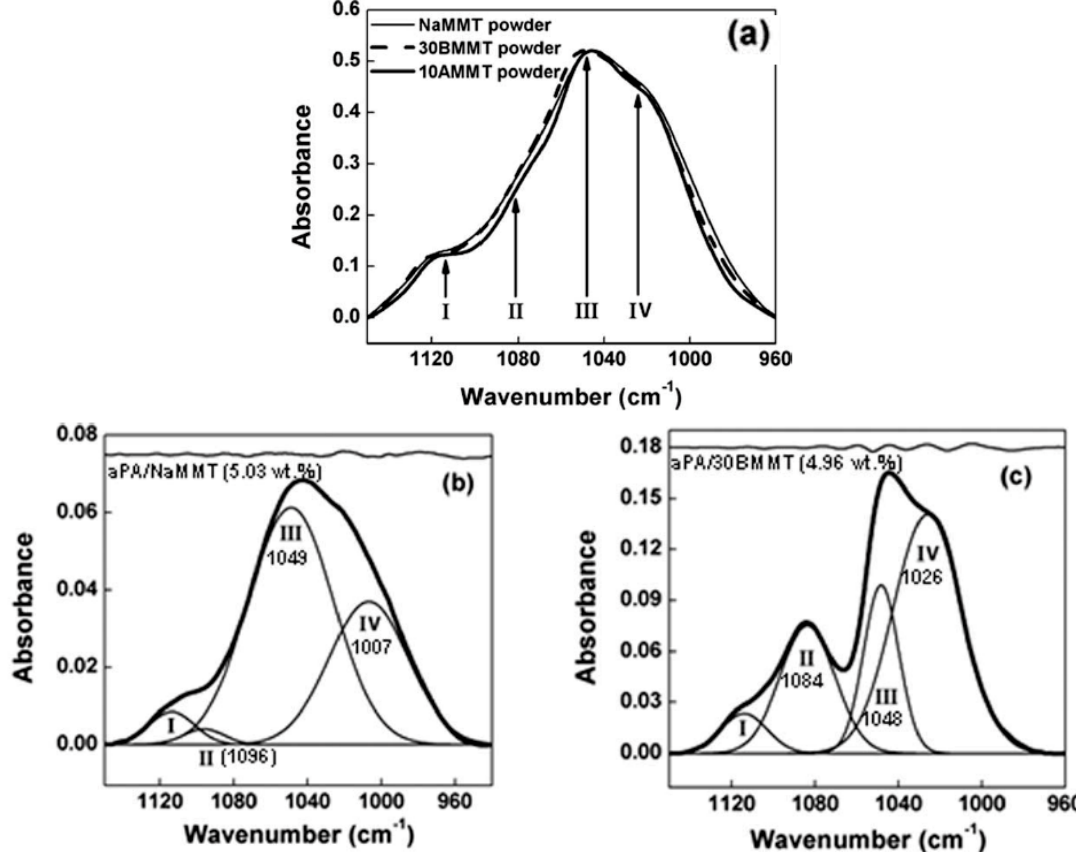
Figure 6. Fourier transform infrared FTIR spectra of: ( a ) sodium montmorillonite (NaMMT) and organoclays (30BMMT) and (10AMMT) respectively intercalated with methyl, tallow, bis-2-hydroxyethyl quaternary ammonium and dimethyl, benzyl, hydrogenated tallow quaternary ammonium; ( b , c ): clays in aPA composites. Reprinted from reference [58] with permission from Wiley.